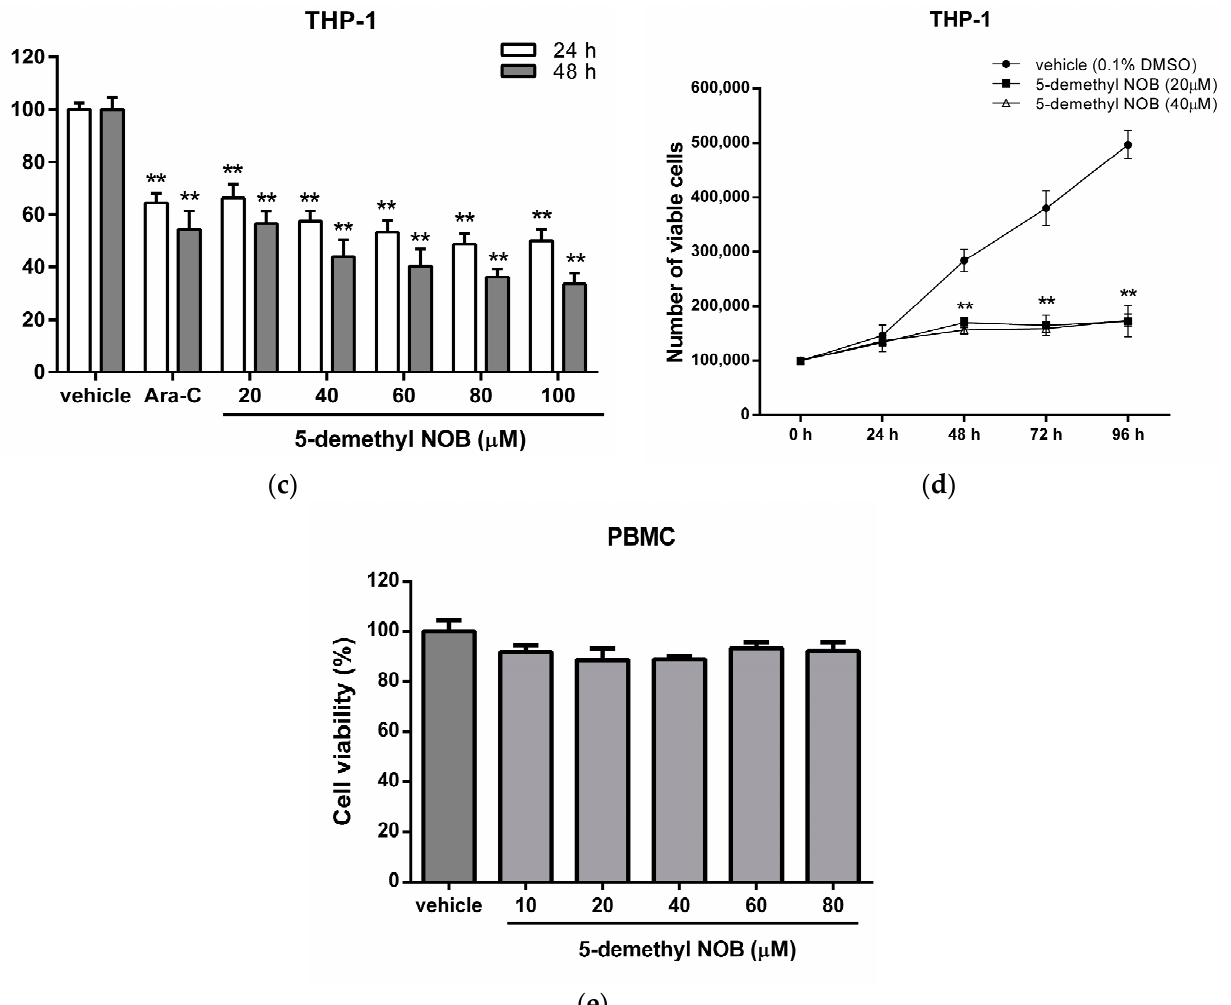
Figure 1. The effect of 5-demethyl NOB on leukemia cell viability. ( a ) The chemical structure of 5-demethylnobiletin (5-hydroxy-6,7,8,3 ′ ,4 ′ -pentamethoxyflavone). ( b ) HL-60, THP-1, U937, HEL and K562 cells were treated with vehicle (0.1% DMSO) or 5-demethyl NOB (20–80 μ M) for 48 h. Cell viability was measured by MTT assay. ( c ) THP-1 cells were treated with vehicle, cytarabine (Ara-C, 20 μ M) or 5-demethyl NOB (20–100 μ M) for 24 and 48 h. Cell viability was measured by MTT assay. ( d ) THP-1 cells (2.5 × 10 5 /mL) were seeded and incubated with 5-demethyl NOB (20 and 40 μ M) for 0–96 h. The number of cells was measured by counting viable cells using trypan blue staining. ( e ) PBMCs were treated with 5-demethyl NOB (10–80 μ M) for 48 h, and cell viability was measured by MTT assay. The data represent the mean ± SD of three independent experiments. ** p < 0.01 represents significant differences compared to the vehicle-treated